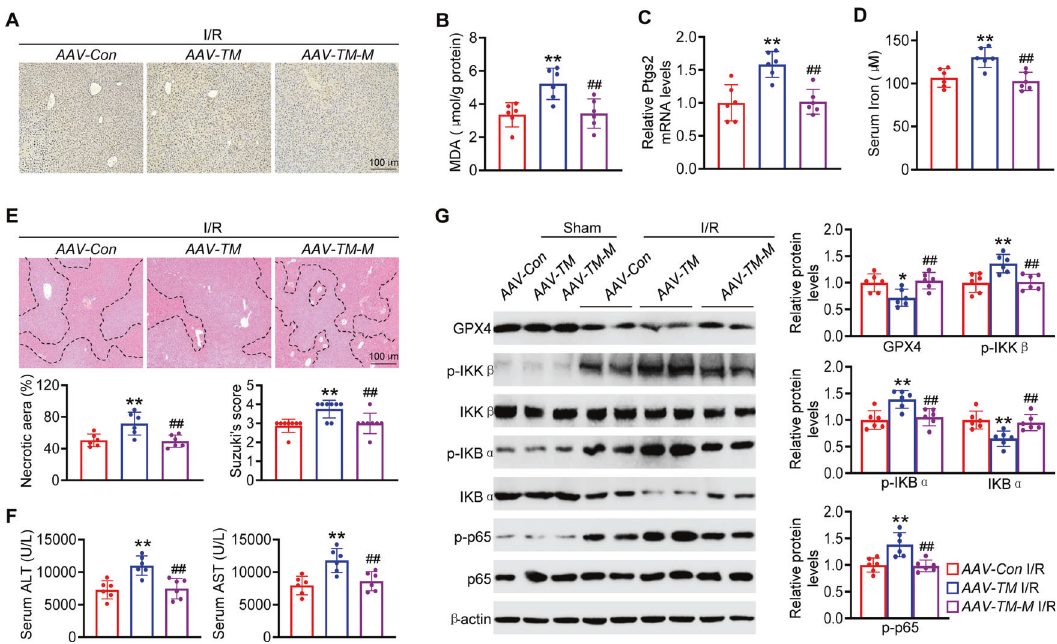
Fig. 7 The interaction between TMEM16A and GPX4 is indispensable for TMEM16A function in hepatic I/R injury. A Representative immunohistochemical staining of 4-HNE in liver sections of AAV-Con- , AAV-TM- , and AAV-TM-M- treated mice subjected to 90 min of hepatic ischemia followed by 24 h of reperfusion. Hepatic levels of B MDA, C PTGS2, and D serum iron content ( n = 6). ** P < 0.01 versus AAV-Con I/R; ## P < 0.01 versus AAV-TM I/R. E Representative H&E staining, necrotic area quanti fi cation, and Suzuki histological score in liver samples, and F serum ALT and AST levels in indicated mice followed by 90 min of ischemia and 24 h of reperfusion ( n = 6 – 8). ** P < 0.01 versus AAV-Con I/R; ## P < 0.01 versus AAV-TM I/R. G Western blot analysis and quanti fi cation of levels of hepatic GPX4 protein and proteins related to the NF- κ B signaling pathway from the indicated groups ( n = 6). * P < 0.05, ** P < 0.01 versus AAV-Con I/R; ## P < 0.01 versus AAV-TM I/R. Data were presented as the mean ±